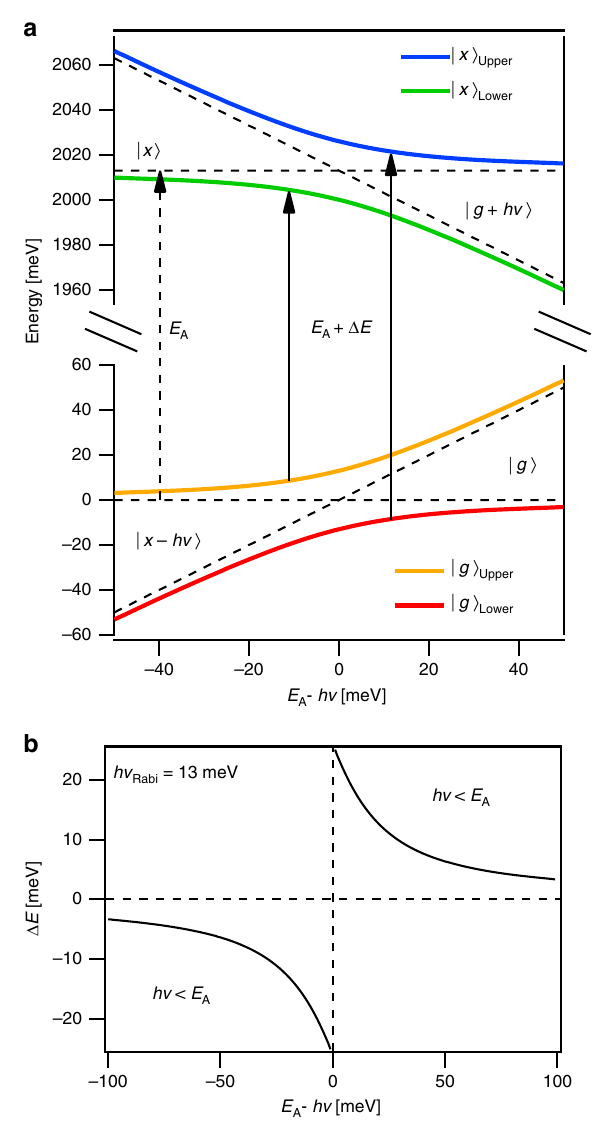
Fig. 3 Two-level dressed-atom model of the optical Stark effect. a Energy- level diagram showing the equilibrium ground, | g 〉 , and exciton, | x 〉 states (dashed horizontal lines) that mix with the photon-dressed states, | g + h υ 〉 and | x − h υ 〉 (dashed diagonal lines), and hybridize. Energy-level repulsion results in upper and lower exciton-polariton bands, e.g. | x 〉 upper and | x 〉 lower , with optical transitions shifted by, Δ E . b The optical Stark shift predicted by the two-level dressed-atom model, calculated from Eq. (3), for h ν R = 13 meV i.e. a Rabi frequency of 105 cm − 1